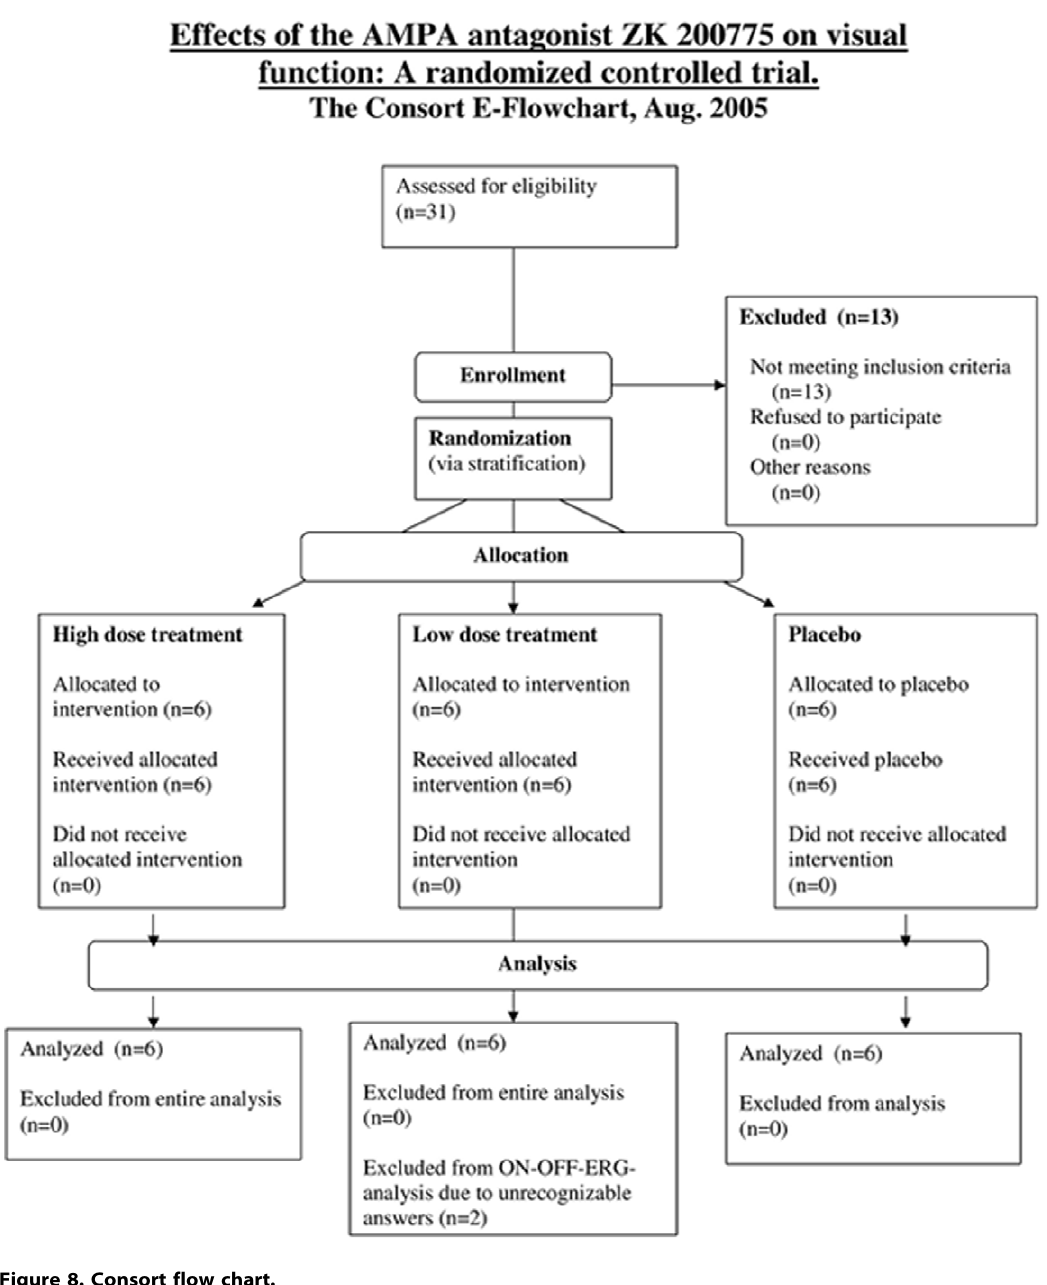
Figure 8. Consort flow chart.